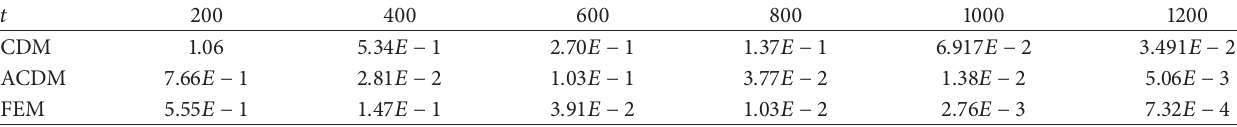
Table 3: The numerical solutions at different time for (1) with 𝑏 = 0.99 , ℎ = 𝜋/16 , and 𝑘 = 1/40 . 𝑡 200